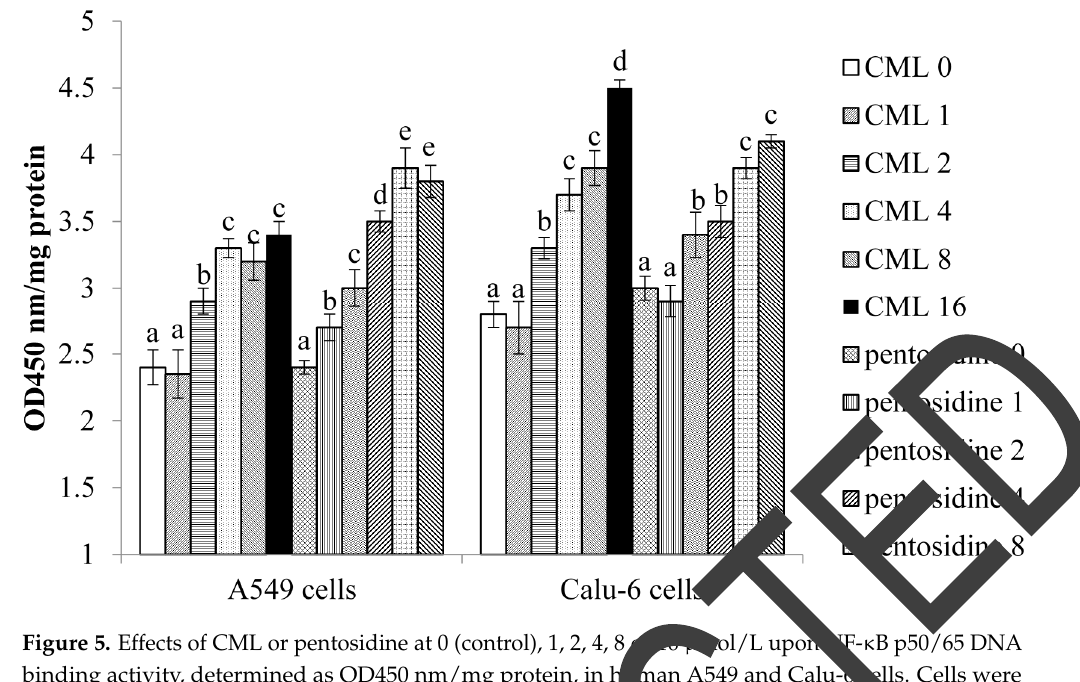
Figure 5. Effects of CML or pentosidine at 0 (control), 1, 2, 4, 8 or 16 μ mol/L upon NF- κ B p50/65 DNA binding activity, determined as OD450 nm/mg protein, in human A549 and Calu-6 cells. Cells were exposed to CML or pentosidine for 18 h at 37 °C. Data are mean ± SD ( n = 10). a–e Means among bars without a common letter differ, p < 0.05.